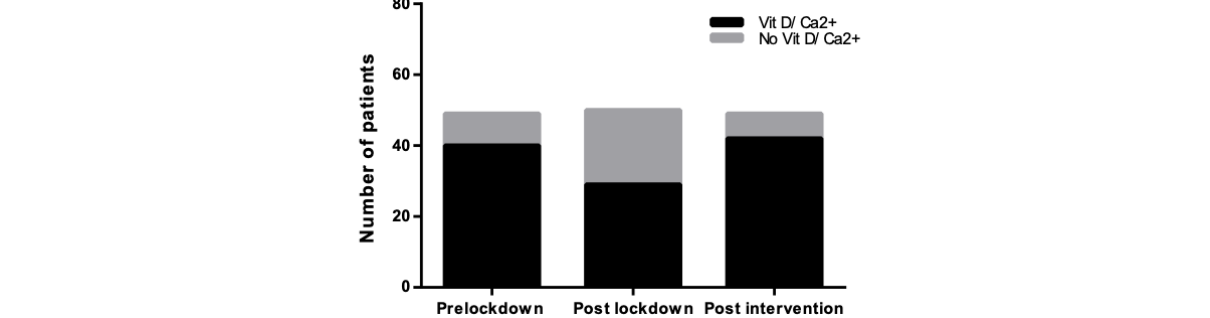
Figure 3. The number of patients receiving correct vitamin D (vit D)/Ca2+ supplements after the lockdown was significantly reduced ( P <.05); post intervention, there was a significant increase in the correct administration of vitamin D/Ca2+ ( P <.01), compared to post lockdown.